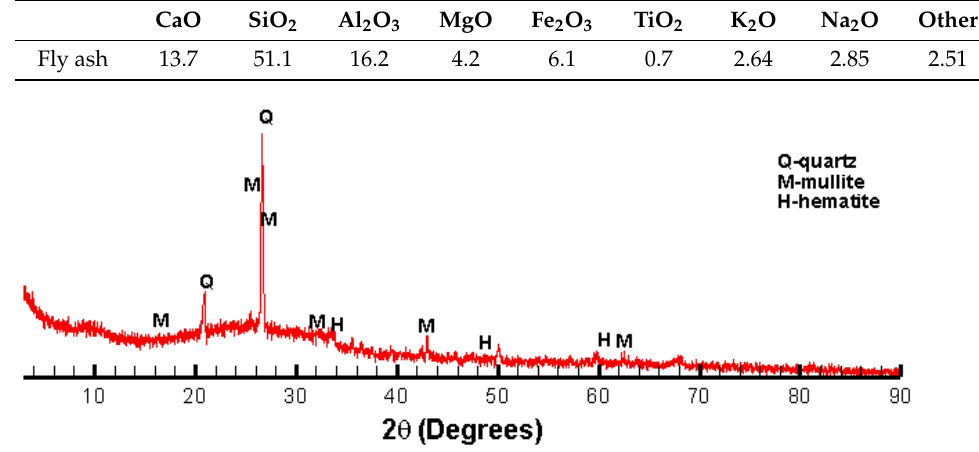
Figure 1. XRD results of the used fly ash sample.